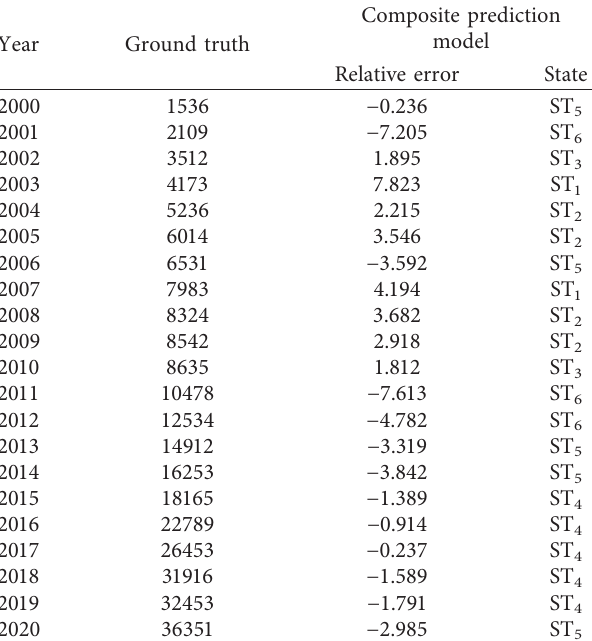
Table 4: Prediction results on regional logistics heat and their errors and